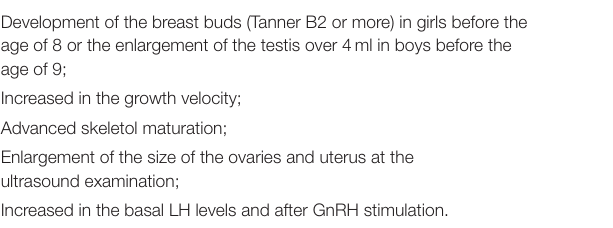
TABLE 1 | Clinical and laboratory evidence of precocious